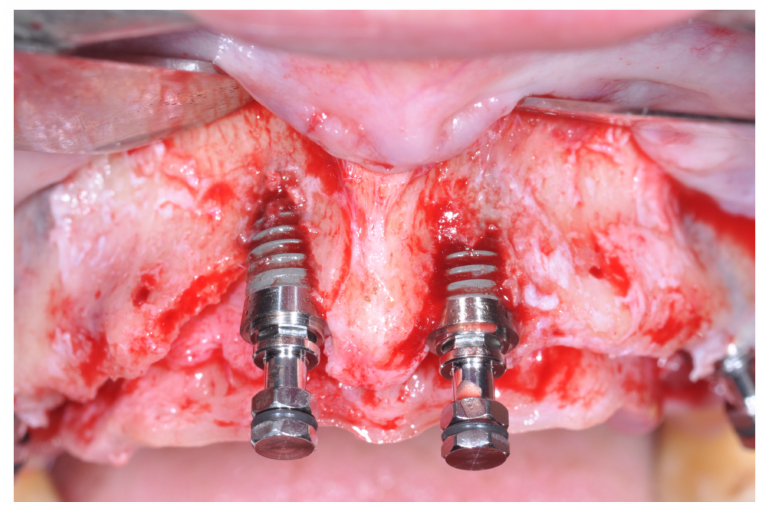
Figure 10. Frontal view of the area to be augmented with the “sling technique”.